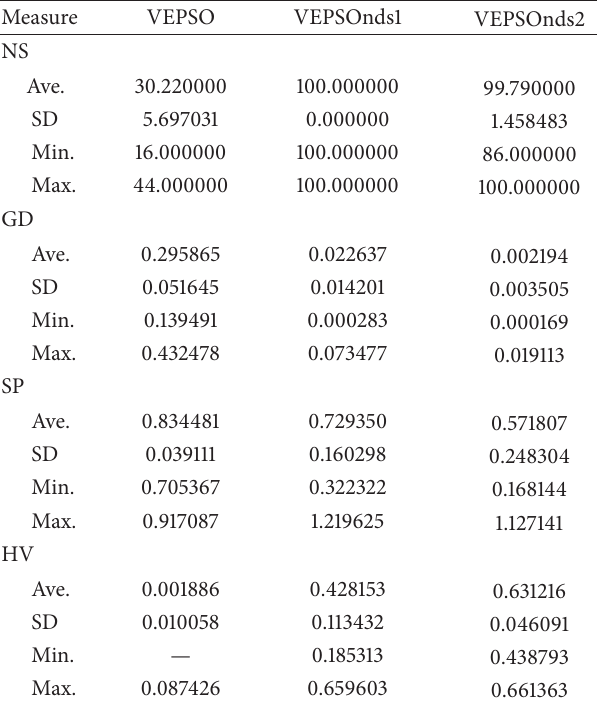
Table 3: Algorithm performance tested on ZDT3 problem.